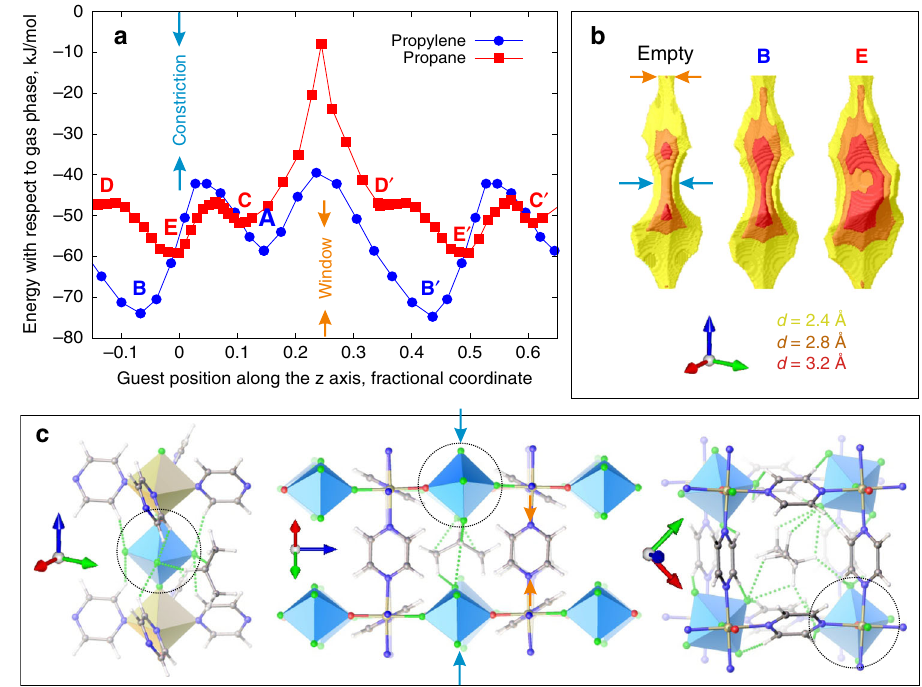
Fig. 3 DFT calculations of the complete MEP through the unit cell. a The representative diffusion pro fi les calculated with climbing image NEB DFT for propylene (blue circles) and propane (red squares) in NbOFFIVE -1-Ni. The guest energy relative to the gas phase is shown as a function of the position of the central carbon on the C 3 H 6 or C 3 H 8 molecule. b The shape of the cavity depicted using three probe sizes with diameters 2.4 Å, yellow, 2.8 Å, orange, 3.2 Å, red, for empty host and in the global minimum con fi gurations B and E . Compared with the empty host, the cavity changes little in the presence of propylene (minimum B ) but considerably in the presence of propane (minimum E ). c Three views of the global energy minimum E in which the propane guest is located in the centre of the cavity ( z = 0) with the adjacent (NbOF 5 ) 2 − anion rotated around the c axis ( c.f ., Fig. 1c) to form two C – H···F contacts with the central carbon. The anion rotation changes the pattern of the intra-framework C – H···F contacts, as now equivalent pyrazines form C – H···F contacts with the same equatorial fl uoride ( c.f ., Fig. 1c). The views along the channel and through the window show seven attractive C – H···F contacts in E that lead propane to produce a distortion of the framework by anion rotation (circled) rather than adopt metastable minimum C where only fi ve such contacts are possible ( c.f ., Fig. 2). Owing to the interactions with the anions, the propane in minimum E in the centre of the cavity is oriented diagonally across the cavity in contrast to all guests in Fig. 2 whose orientation is de fi ned by the excluded volume interactions with the pyrazines. The guest orientation at 300 K as a function of its location in the cavity is shown in Supplementary Fig.